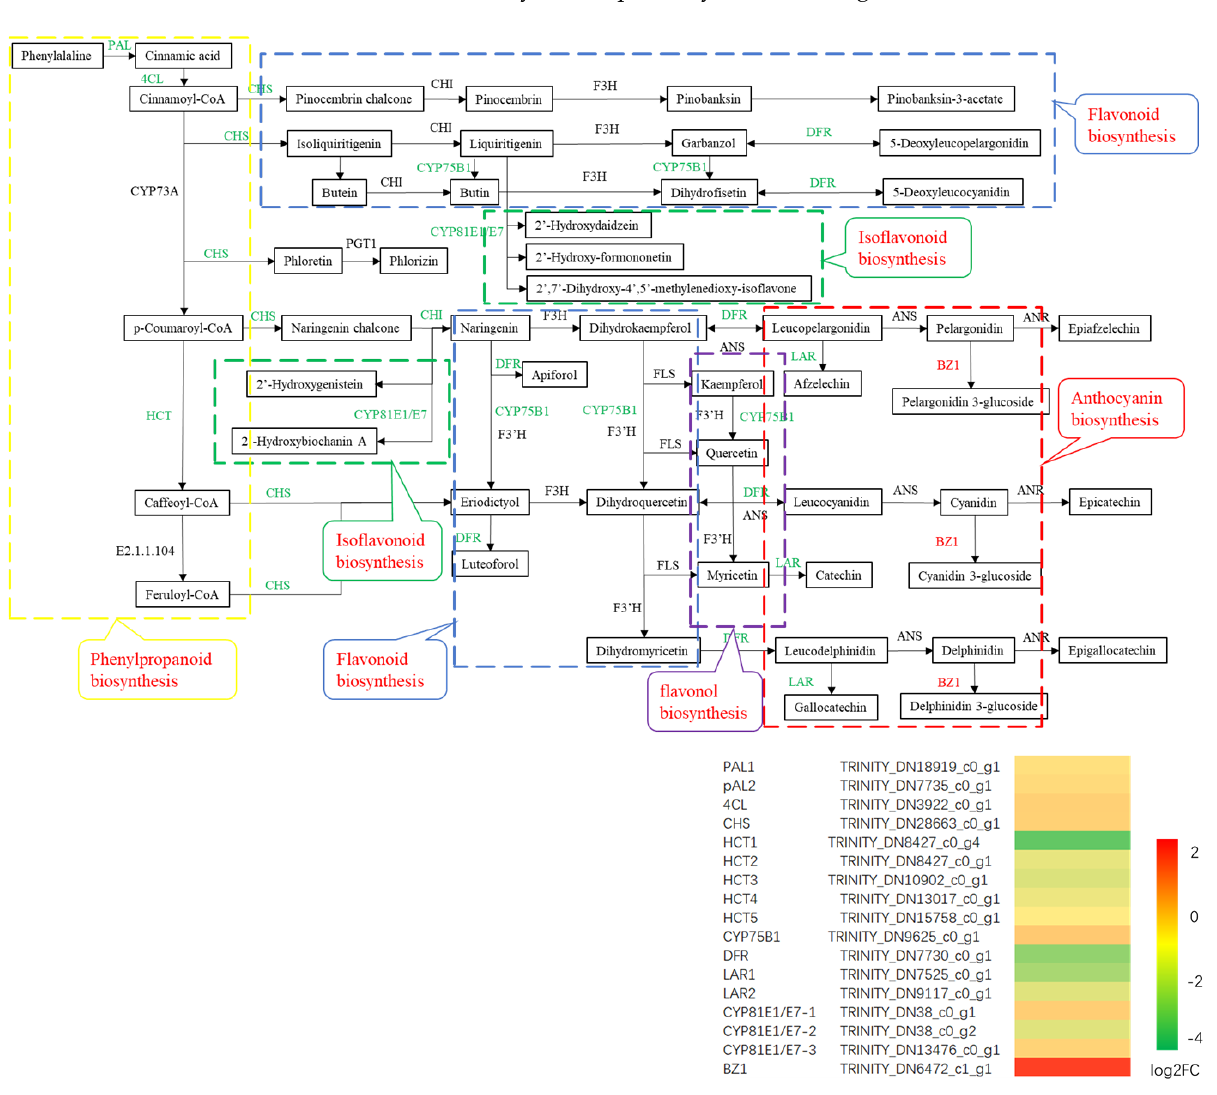
Figure 8. Expression of genes involved in flavonoid biosynthetic pathways in P. tatarinowii ‘Jinyuyuan’ leaves.